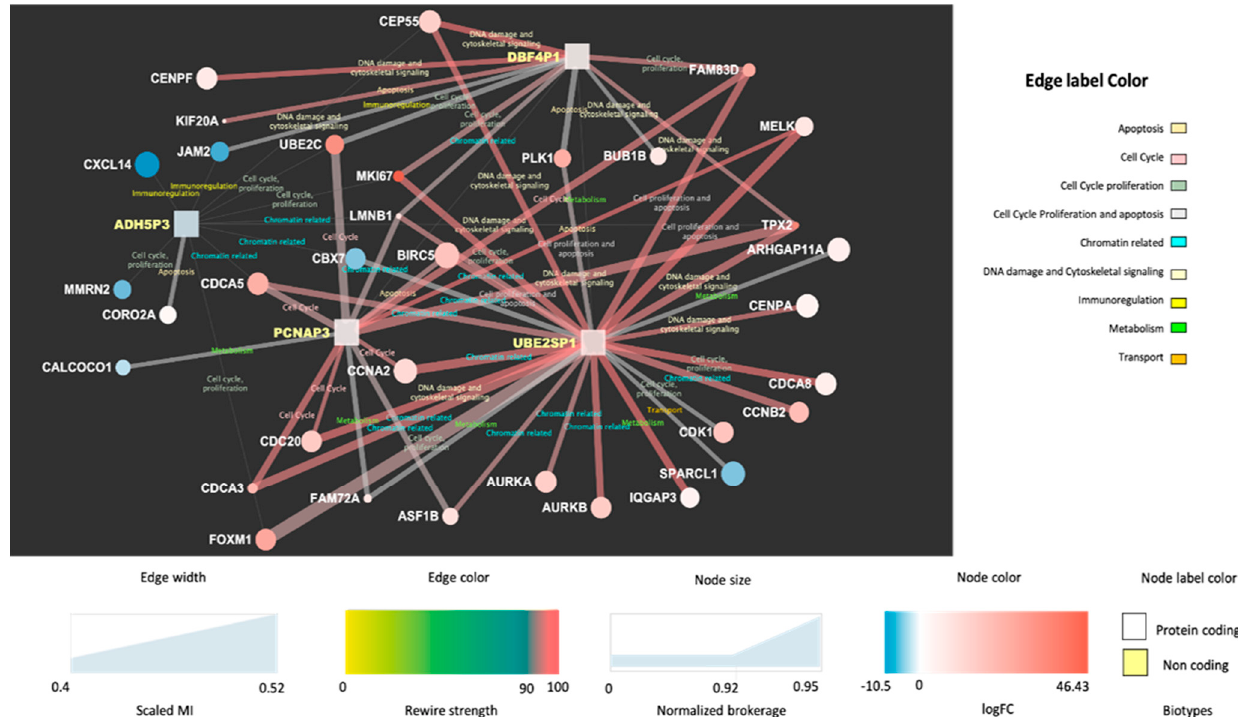
Figure 2. Basal map with top brokerage ncRNAs: DBF4P, ADH5P3, PCNAP3, UBE2SP1.